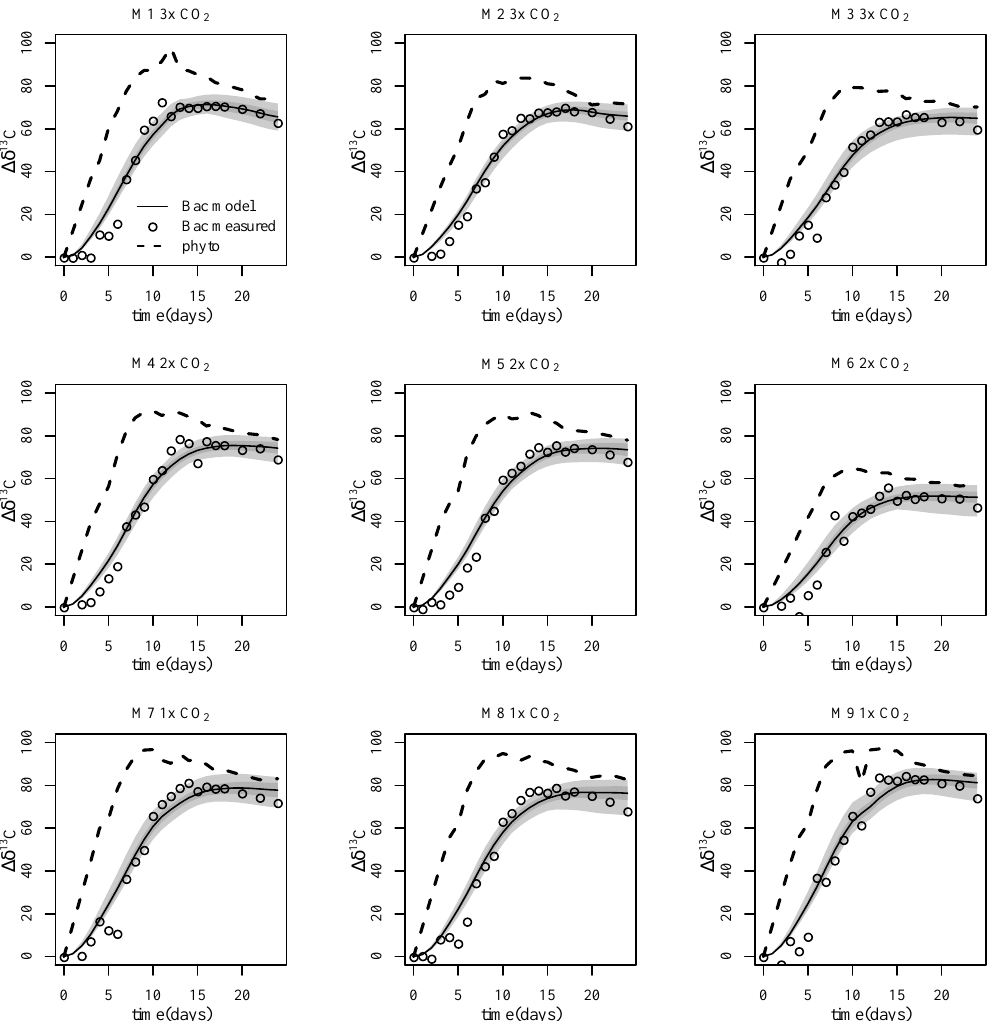
Fig. 6. Model simulations of 13 C transfer from phytoplankton to heterotrophic bacteria for individual mesocosms. Phytoplankton 1δ 13 C data (dashed line) are used as forcing function for model prediction (solid line; Bacteria (Bac) model) of bacterial 1δ 13 C data (open dots; Bac measured). Dark and light grey areas give 95% limits on model uncertainty and in predicting new observations, respectively (see